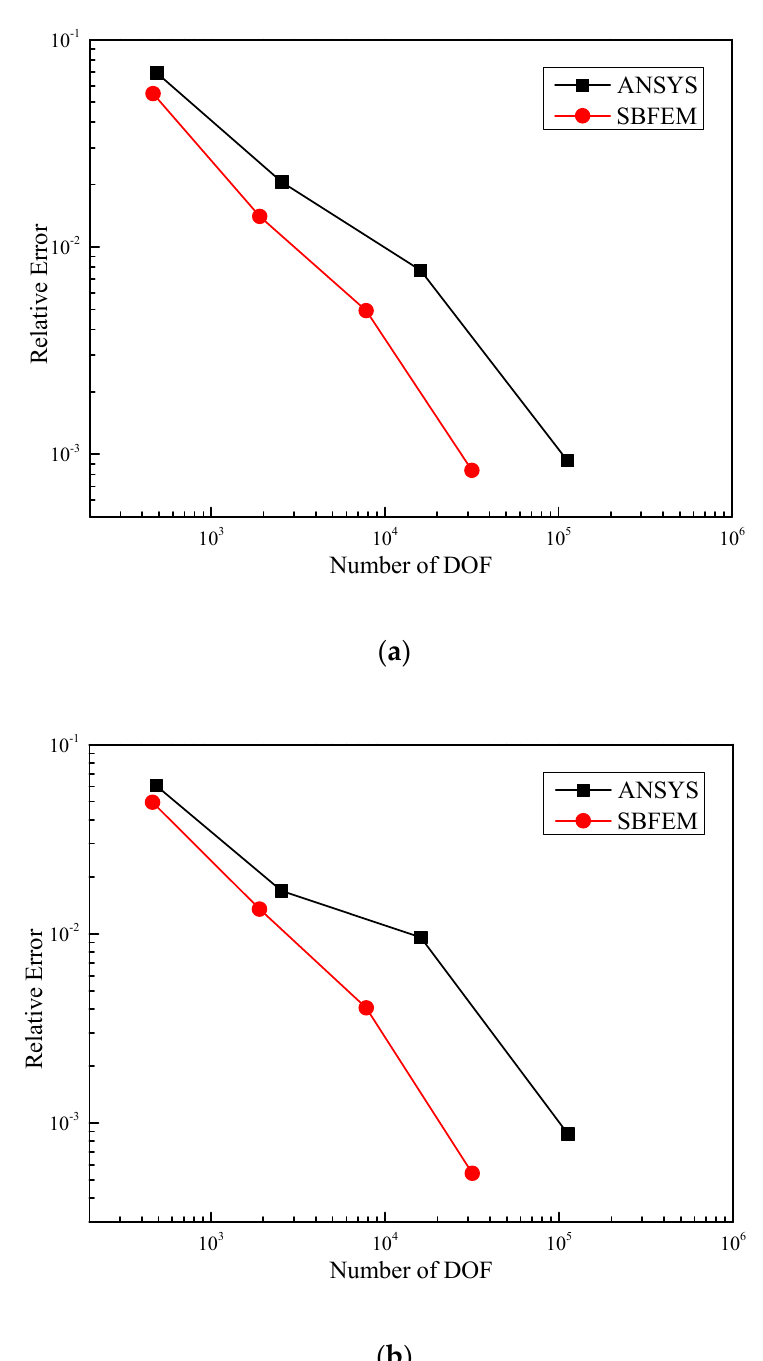
Figure 5. The relative error of displacements in the Z direction vs. number of DOF. ( a ) The relative error of displacement in Z direction at endpoint C. ( b ) The relative error of in Z direction at endpoint D.